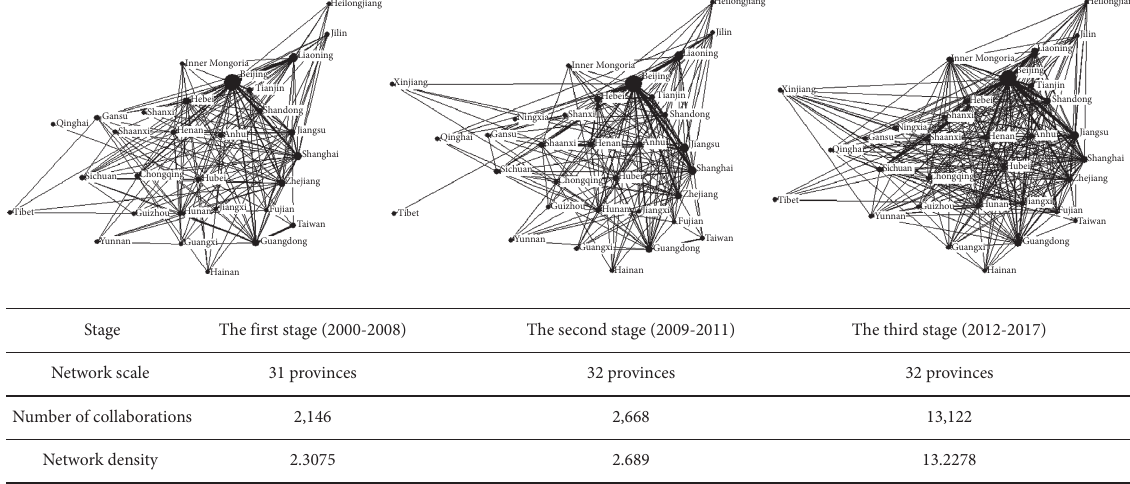
Figure 7: Spatial map of interprovincial collaborative innovation network.